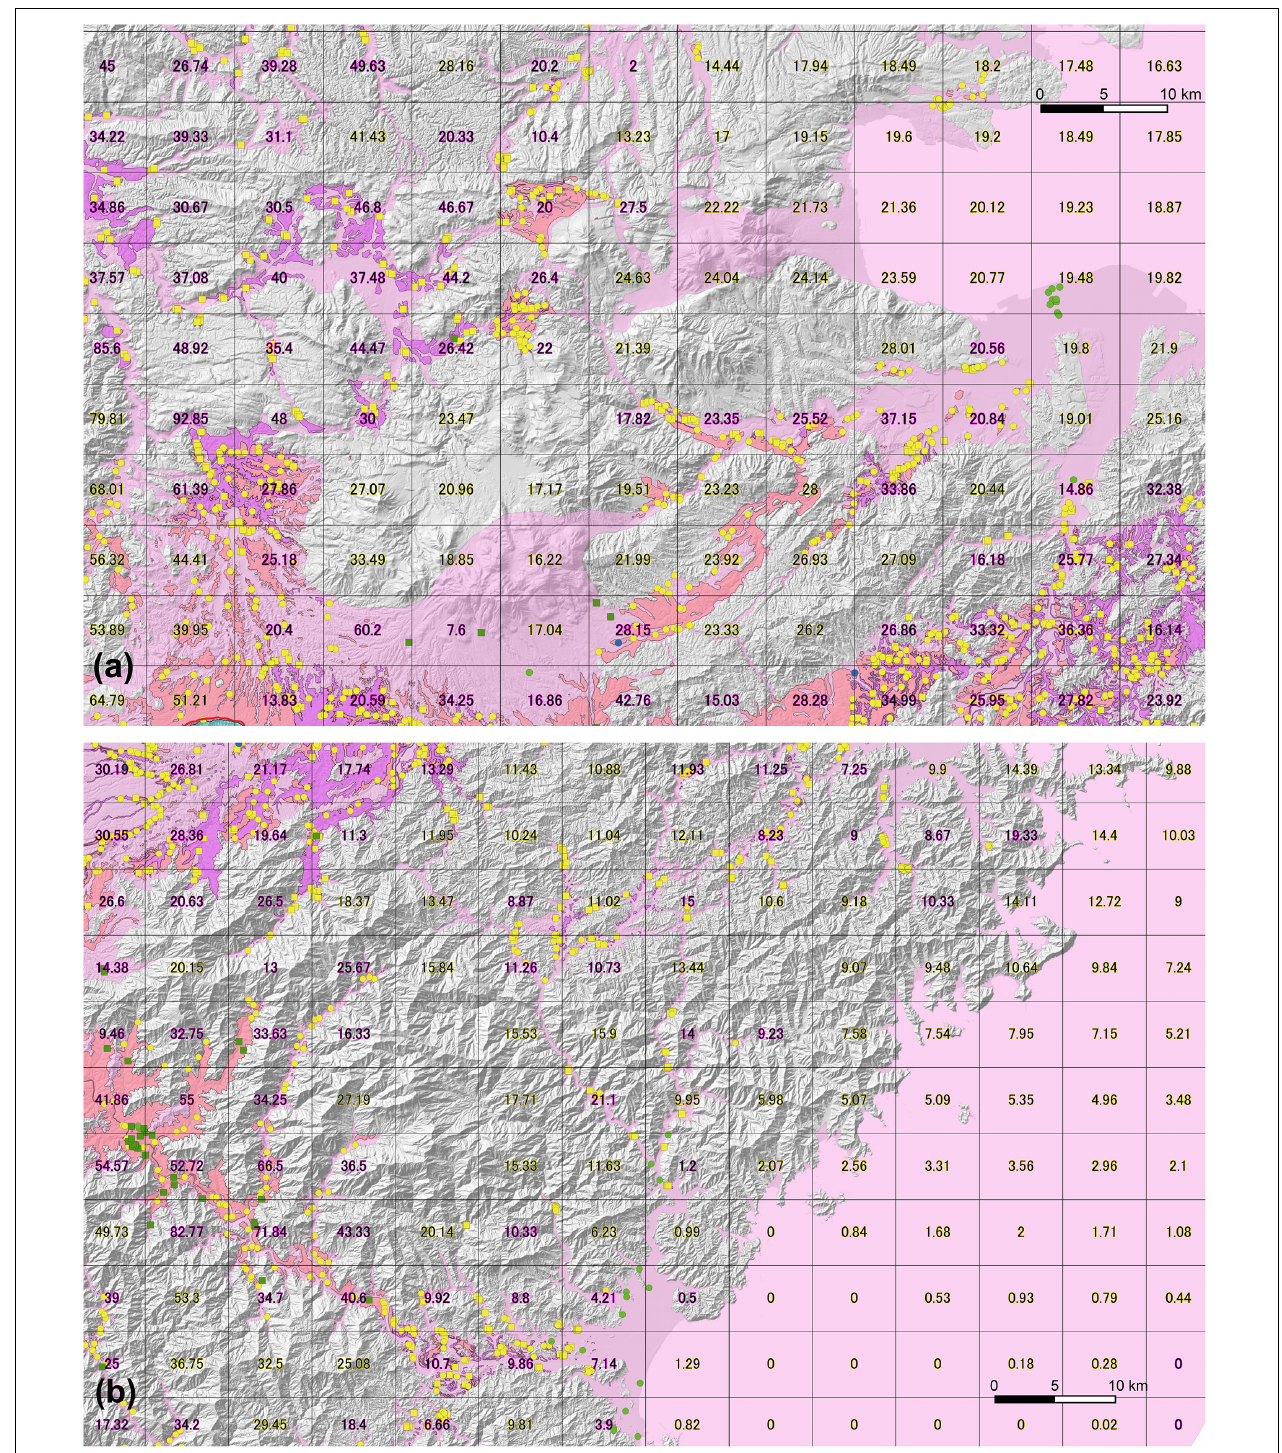
FIGURE 7 | Estimated thickness of Aso-4 PDC deposit. Welded PDC deposits at N and NE side of Aso caldera (a) and non-welded PDC deposits at E and SE side of Aso caldera (b) . Orange-colored parts are the non-welded facies of Aso-4 PDC deposits (current exposure). Purple-colored parts are the welded-facies (current exposure). Light pink-colored parts are the estimated original distribution of the Aso-4 PDC deposit. Purple-colored rim numbers are the average (mean) thickness of all points data within the cell. Yellow-colored rim numbers are the estimated thickness values using the ordinary kriging method. Symbol colors and type of point data are the same as Figure 6 . The Geospatial Information Authority of Japan (GSI) Tile Map (Shaded relief map) is used as the base map.